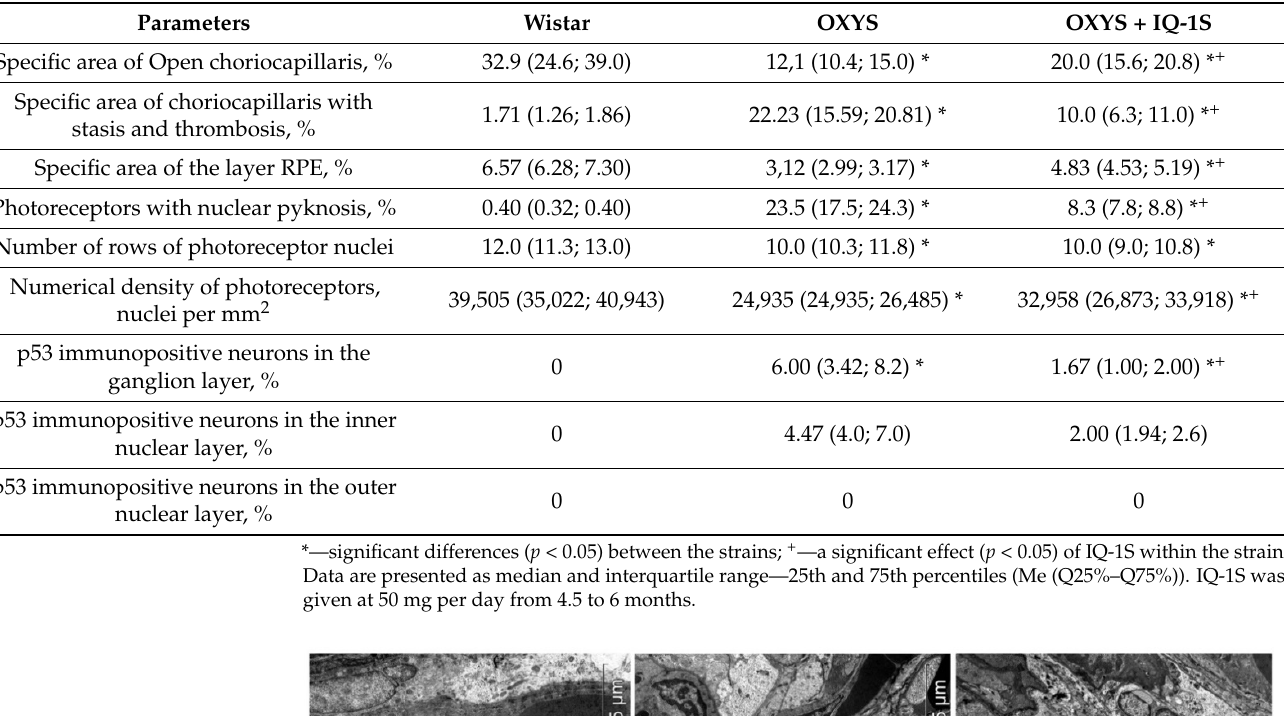
Table 1. Effects of IQ-1S on the morphometric parameters of the Retina of OXYS Rats. Parameters